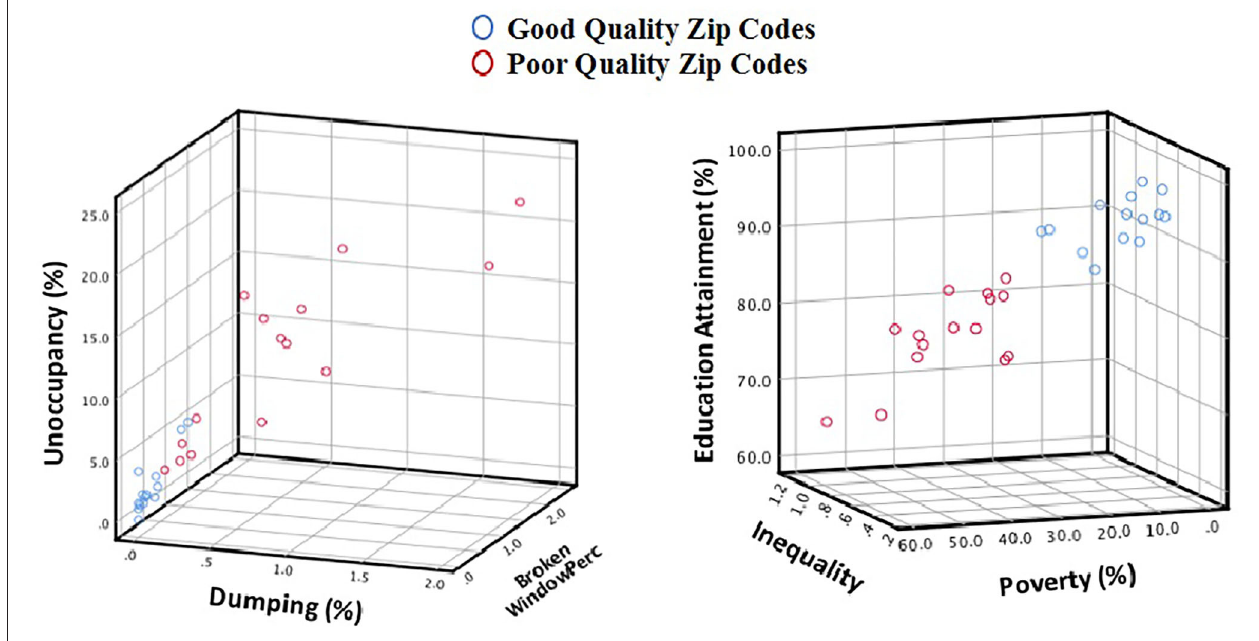
FIGURE 1 | Visualization of neighborhood metrics for good- and poor-quality zip codes.